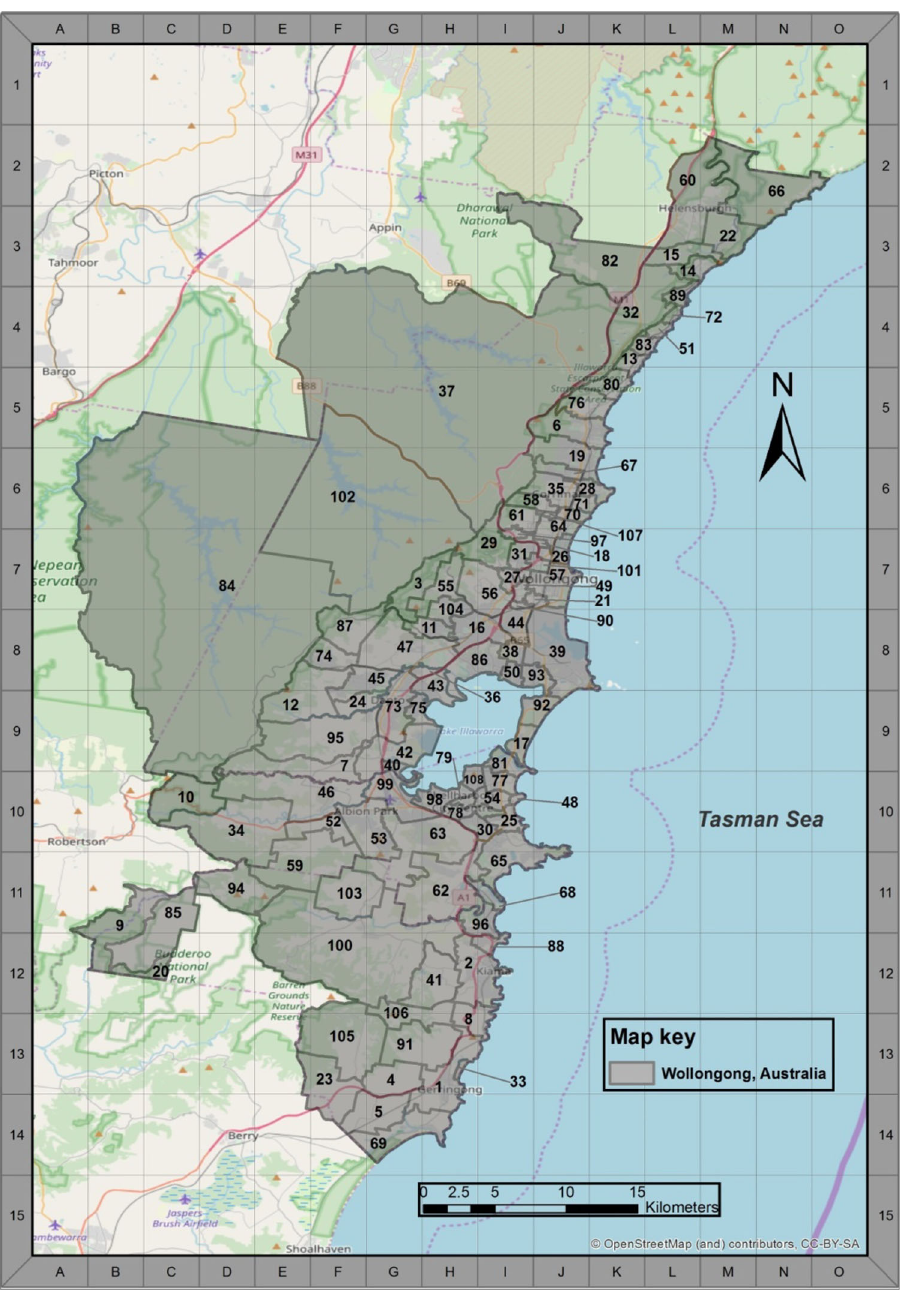
Fig. 1 Study Area: Wollongong, Illawarra region, New South Wales, Australia. Source Background layer